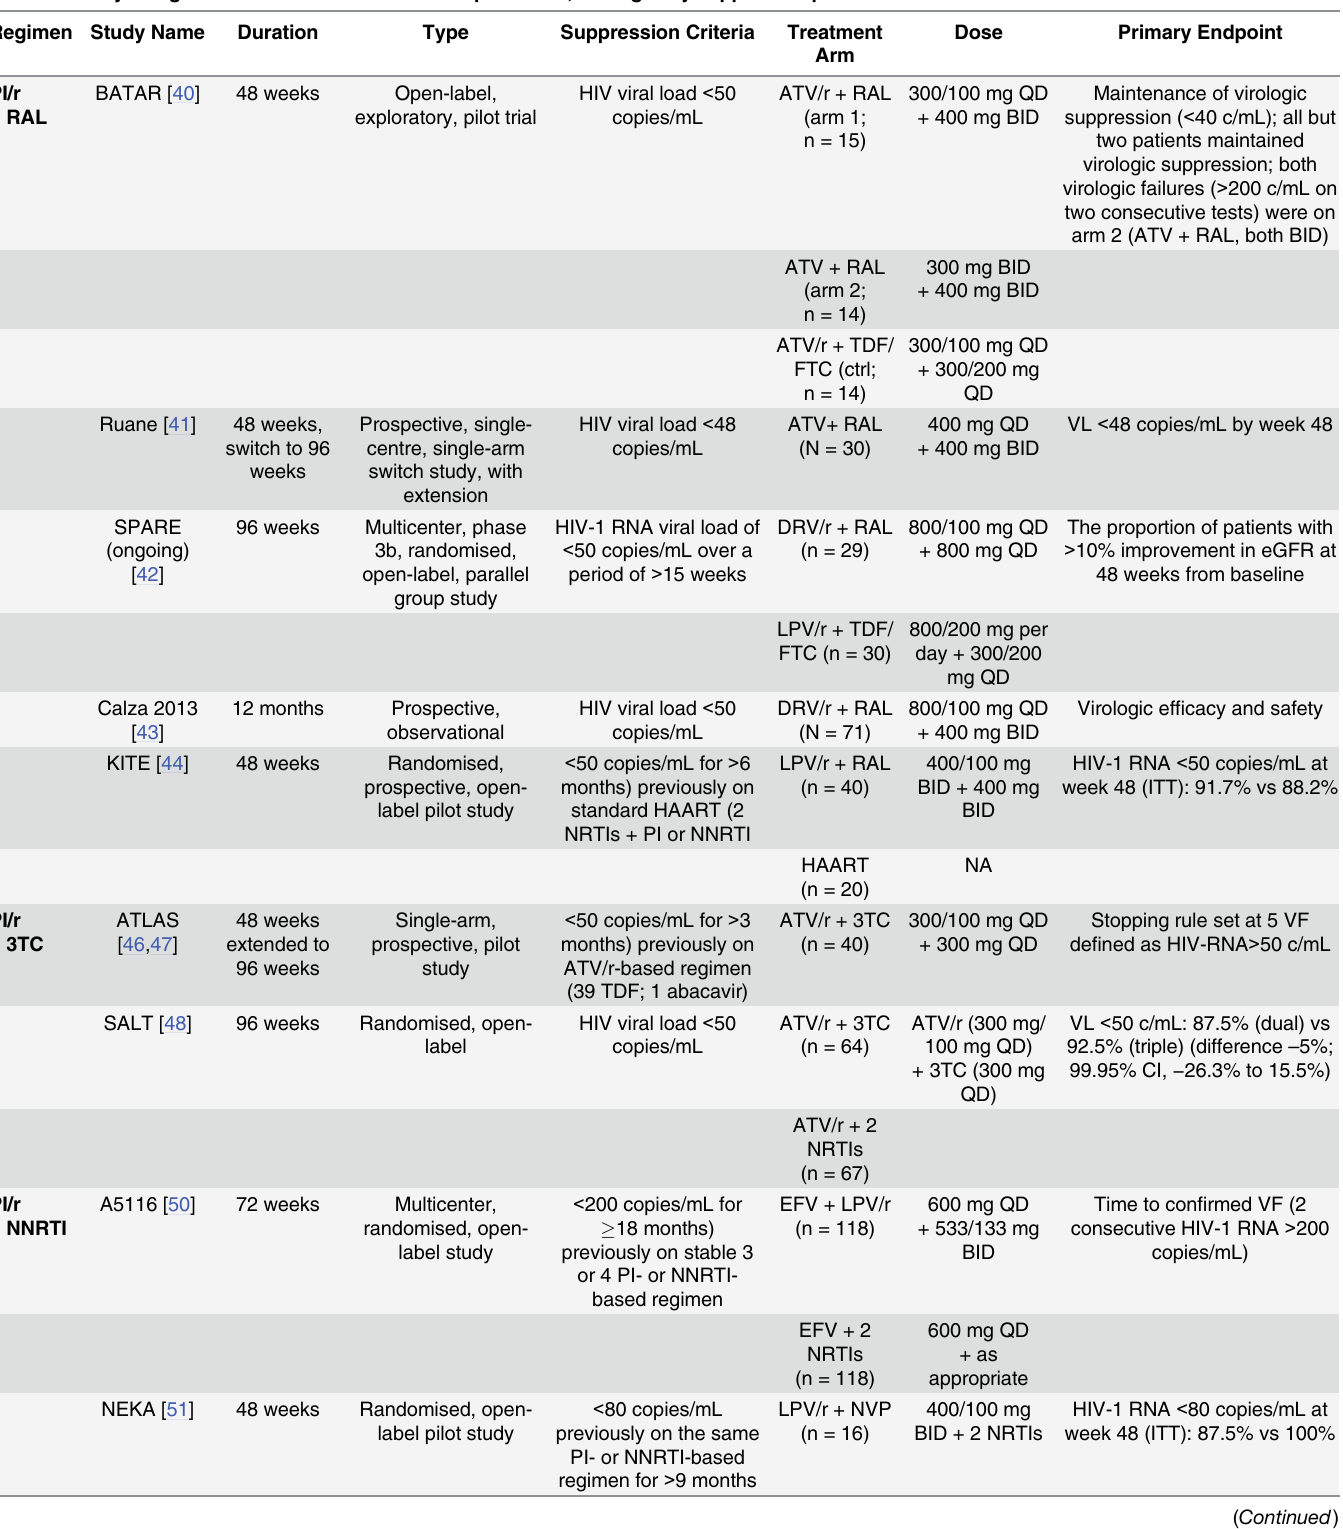
Table 4. Study designs for identified trials in ARV-experienced, virologically suppressed